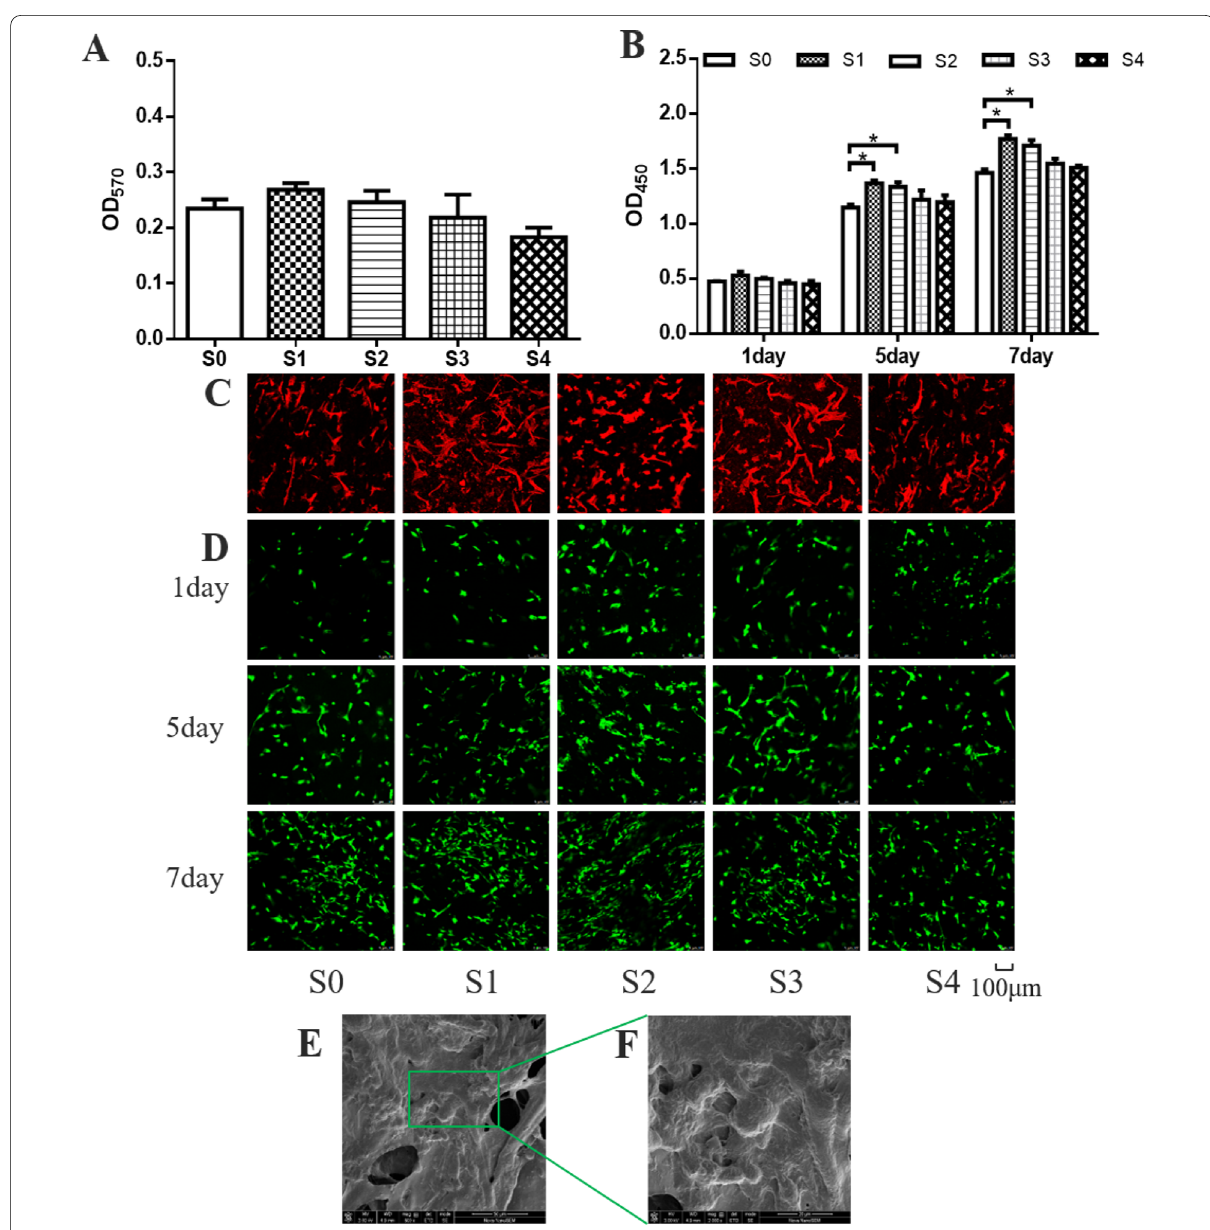
Fig. 6 Cells proliferation on scaffolds. A The HUMSCs viability on the scaffolds after 3 days. B The HUMSCs proliferation after seeding on the scaffolds for 1, 5, and 7 days. C Skeleton of the HUMSCs on the scaffolds after 3 days. D The live/dead staining of HUMSCs after seeding on the scaffolds for 1, 5, and 7 days. E SEM images of the HUMSCs after seeding on the S1 scaffolds for 7 days. Scale bar: 50 μm. F were that of the area framed by green. Scale bar: 20